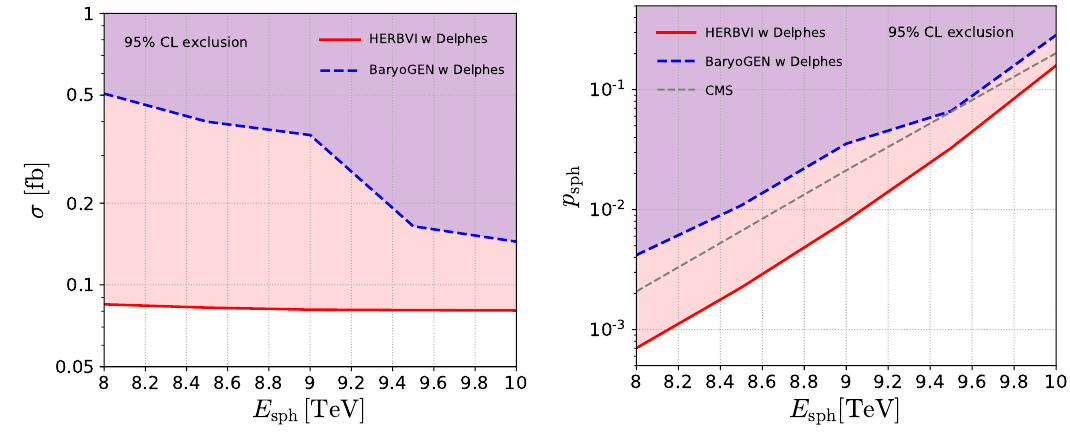
Figure 6 . The 95 % CL exclusion limits obtained by recasting CMS black hole-sphaleron anal- ysis [42] in the ( E sph vs (cid:27) ) [left panel] and ( E sph vs p sph ) [right panel] planes. The light-red and light-blue regions are excluded for HERBVI and BaryoGEN ,